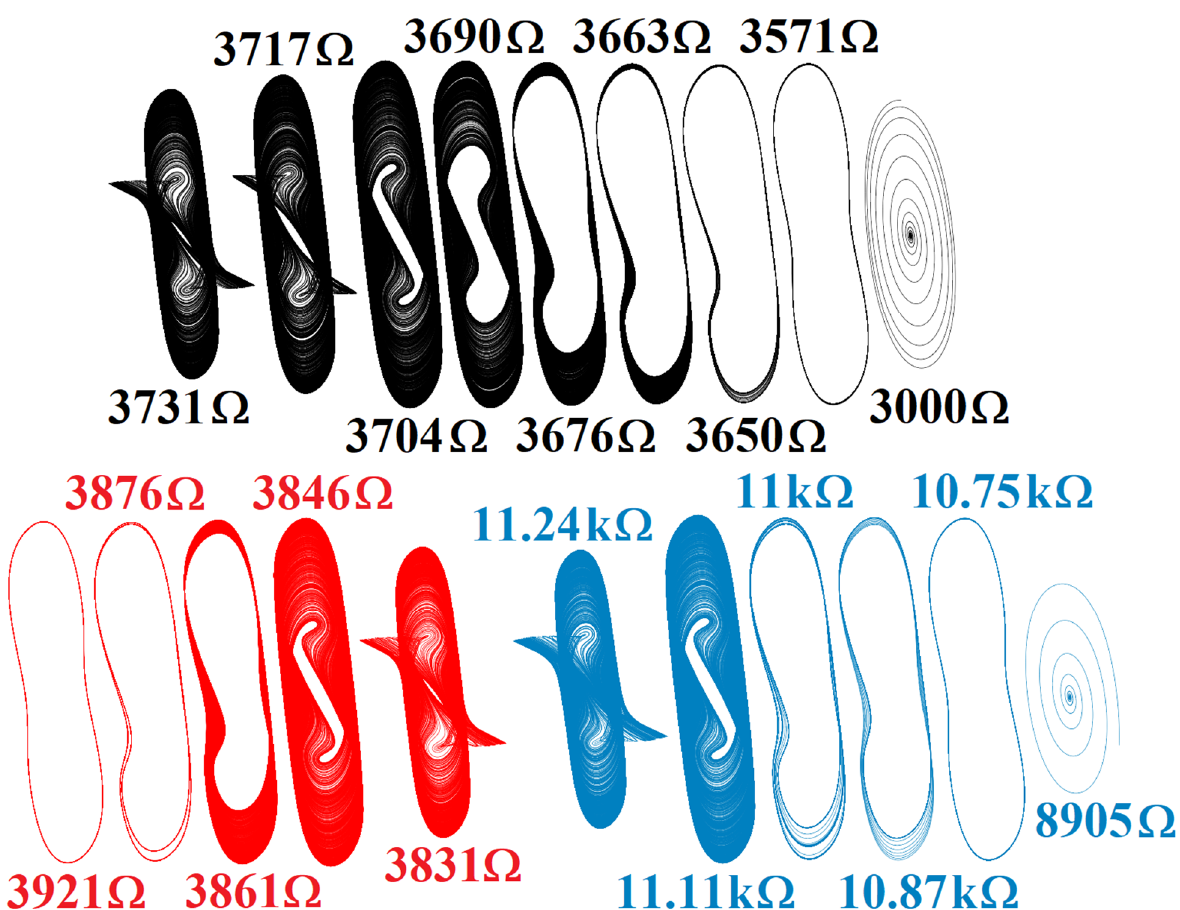
Figure 18. Bifurcation scenarios plotted as two-dimensional projections of state orbit visualized for dynamical system Equation (1) with parameter group Equation (8) via small changes of a variable resistor R 1 (black), R 2 (red), and R 3 (blue).